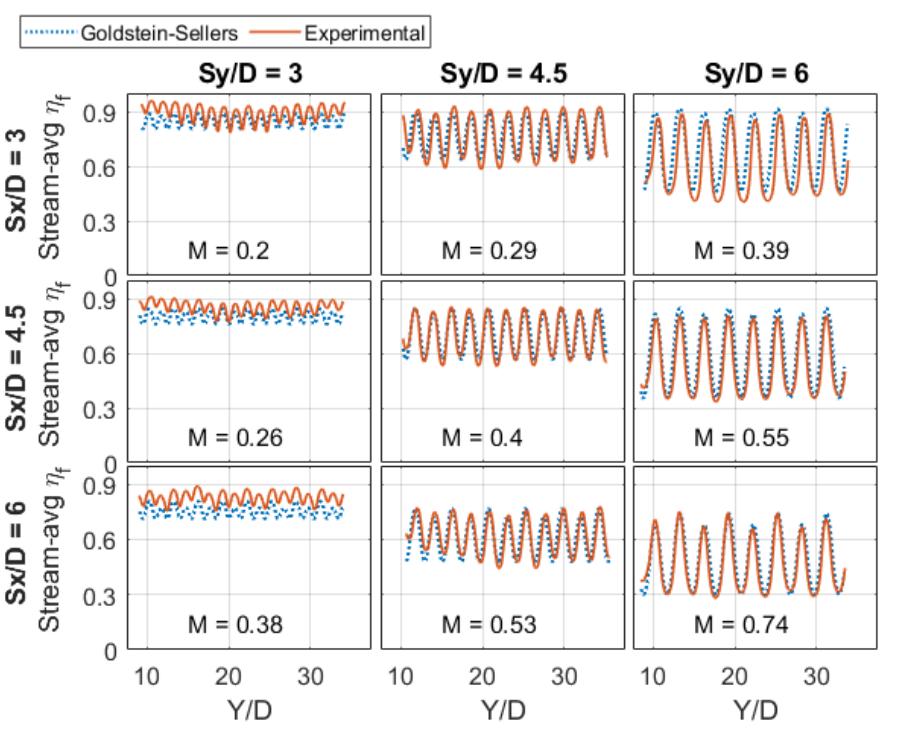
Figure 18. A comparison of numerical and experimental streamwise-averaged film effectiveness for m ∗ =